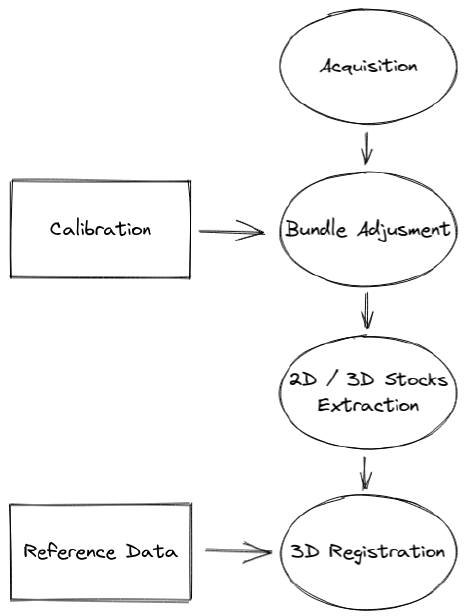
Figure 5: Overview of our non-rigid registration method.